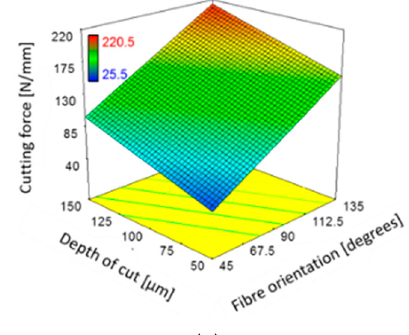
Figure 23. The combined effect on bounce back for ( a ) fibre orientation and cutting depth at constant α : 10°; V c : 570 mm/min; ( b ) fibre orientation and rake angle at constant DOC: 100 µm; V c : 570 mm/min; ( c ) rake angle and cutting depth of constant θ : 90°; V c : 570 mm/min.